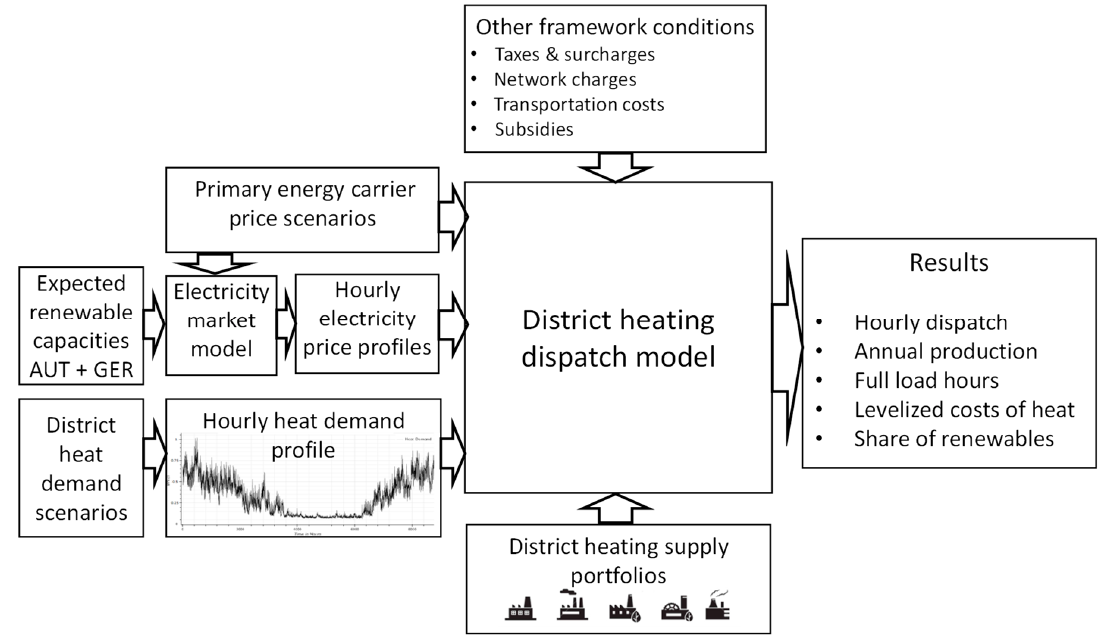
Figure 1. Schematic overview of the methodological framework.